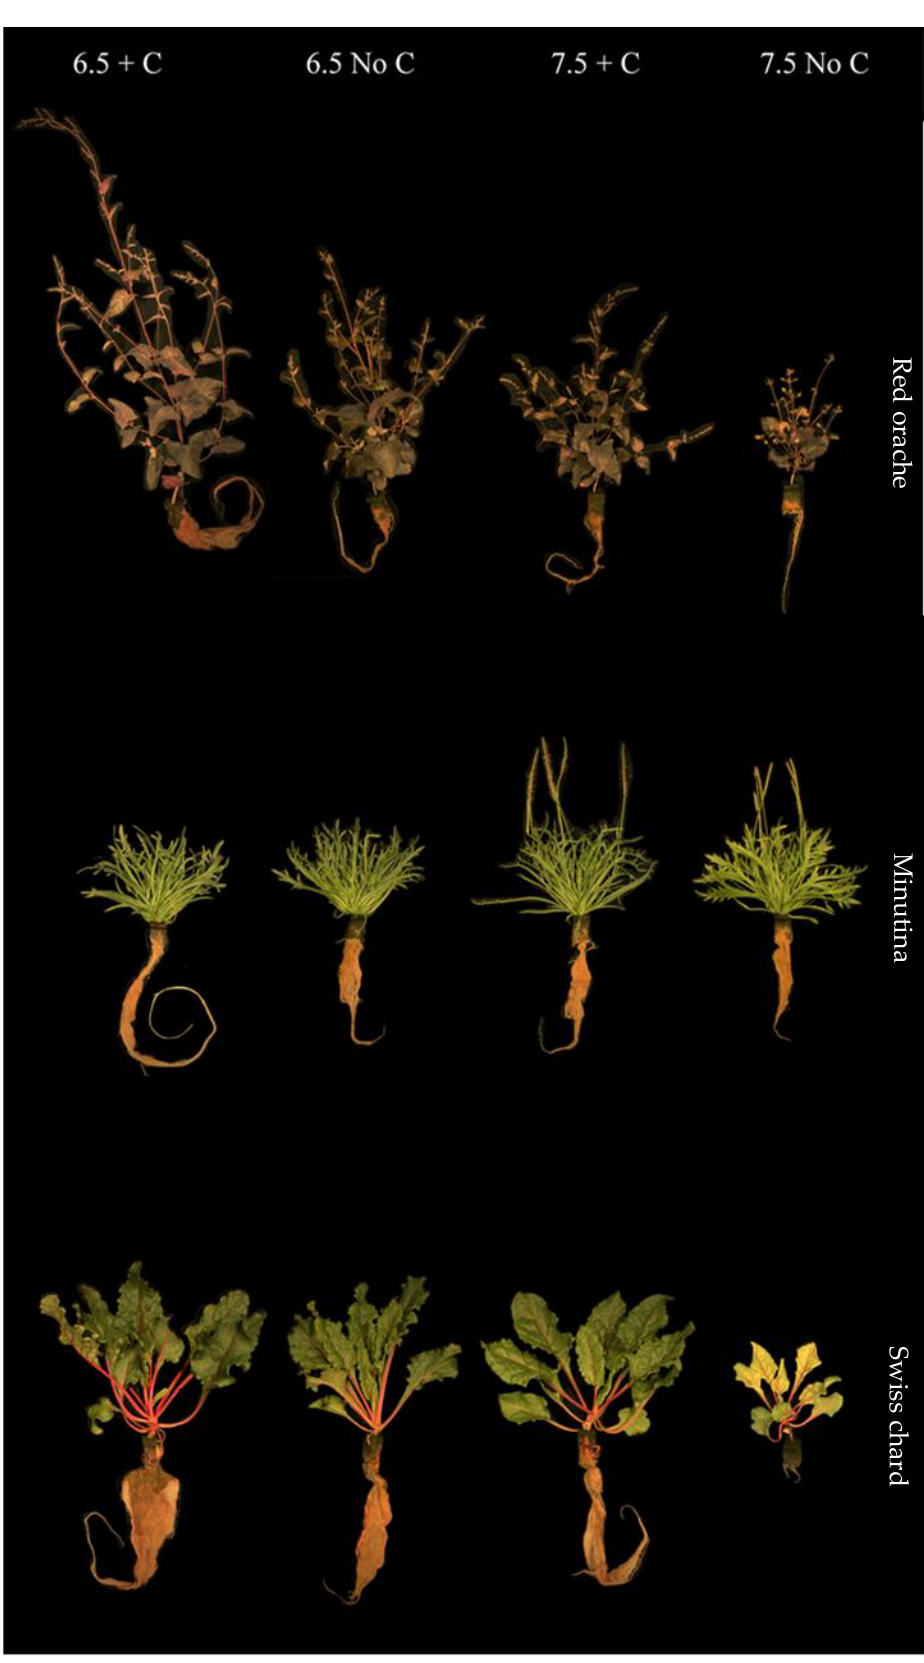
Figure 2. Plants harvested from the first 4 weeks.